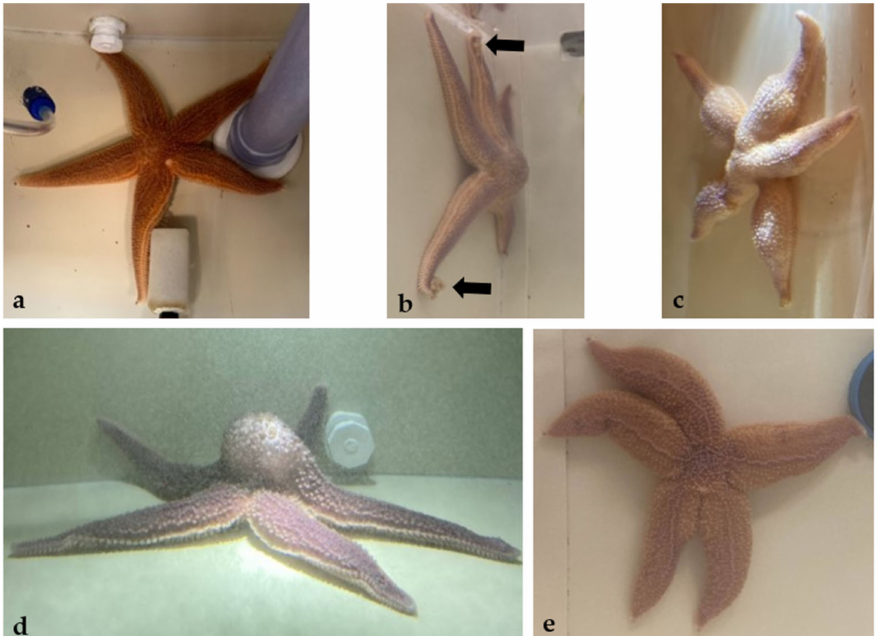
Figure 2. Photographs of adult common sea stars ( Asterias rubens ) taken during the time frame of 14 days of exposure to environmental stressors: ( a ) normal appearance and behavior (pH group); ( b ) sea star with pyloric ceca protruding from arm tips (solid arrows) (temperature group); ( c ) sea star with abnormal body wall contour on arms (temperature group); ( d ) sea star with abnormal body wall contour focused on central disc (hypoxia group); ( e ) sea star with inflated appearance (temperature group).